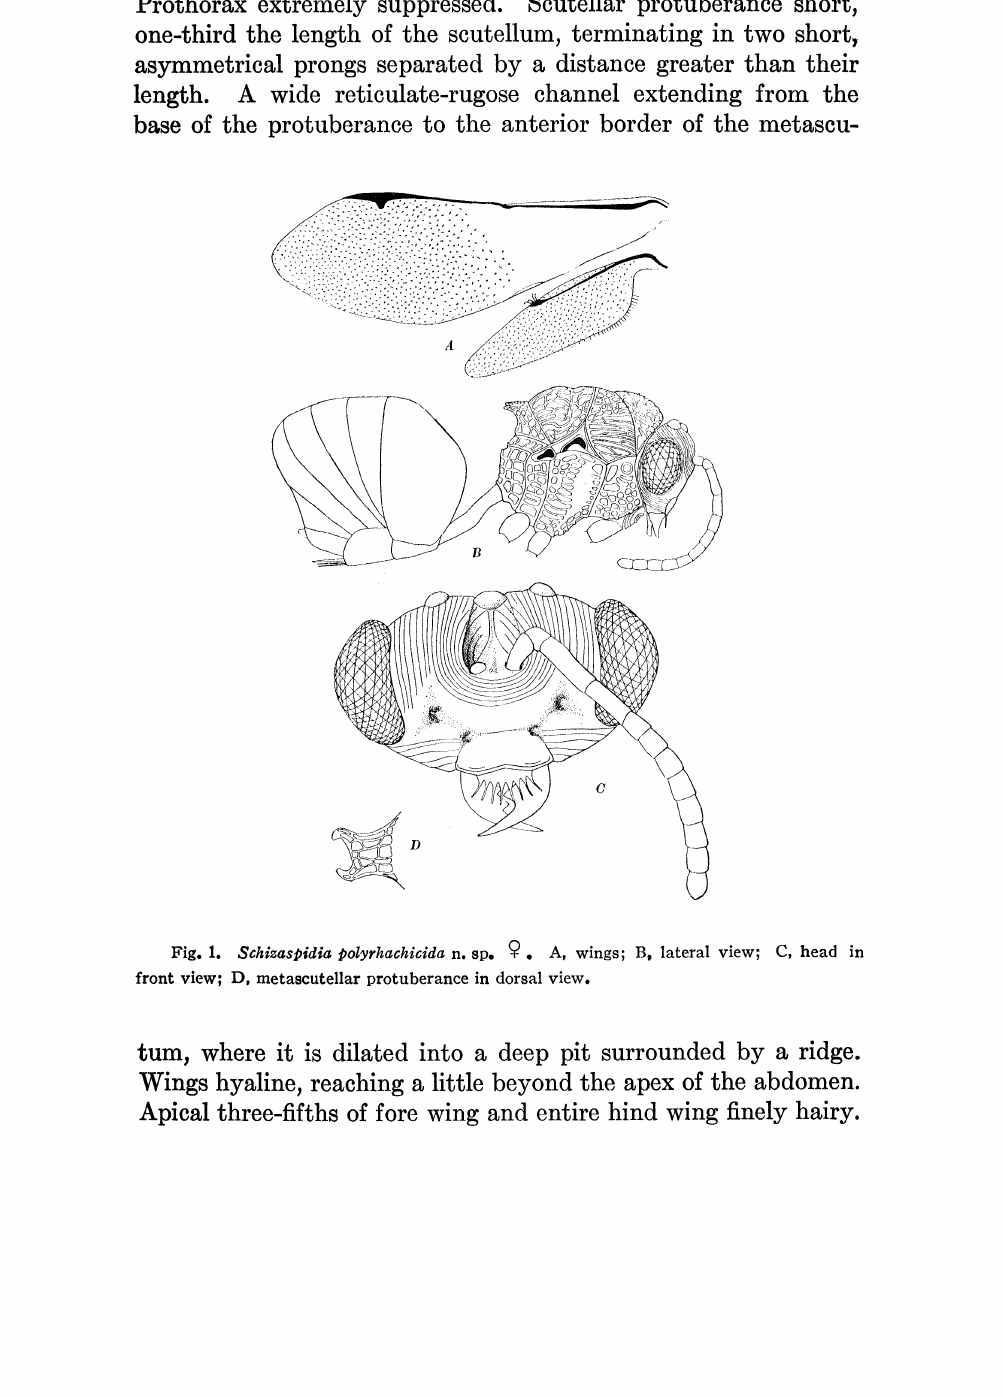
Fig. 1. Schizaspidia polyrhachicida n. sp. A, wings; B, lateral view; C, head in front view; D, metascutellar protuberance in dorsal